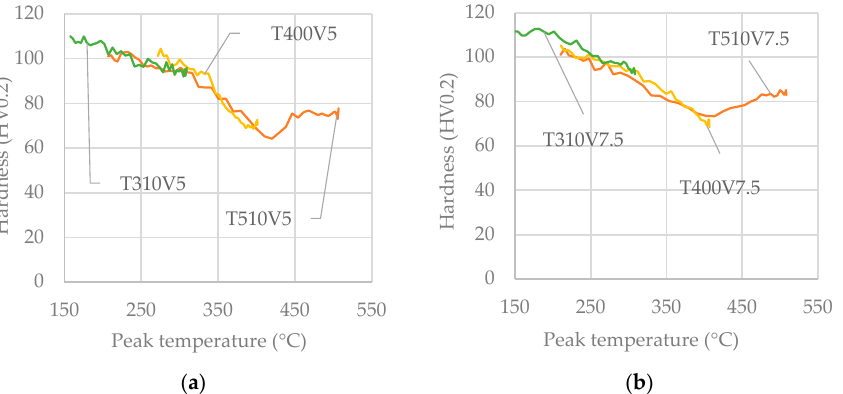
Figure 22. ( a ) Hardness trend as a function of peak temperature related to laser treatments with a speed of 5 mm/s (T4 state); ( b ) Hardness trend as a function of peak temperature related to laser treatments with a speed of 7.5 mm/s (T4 state).